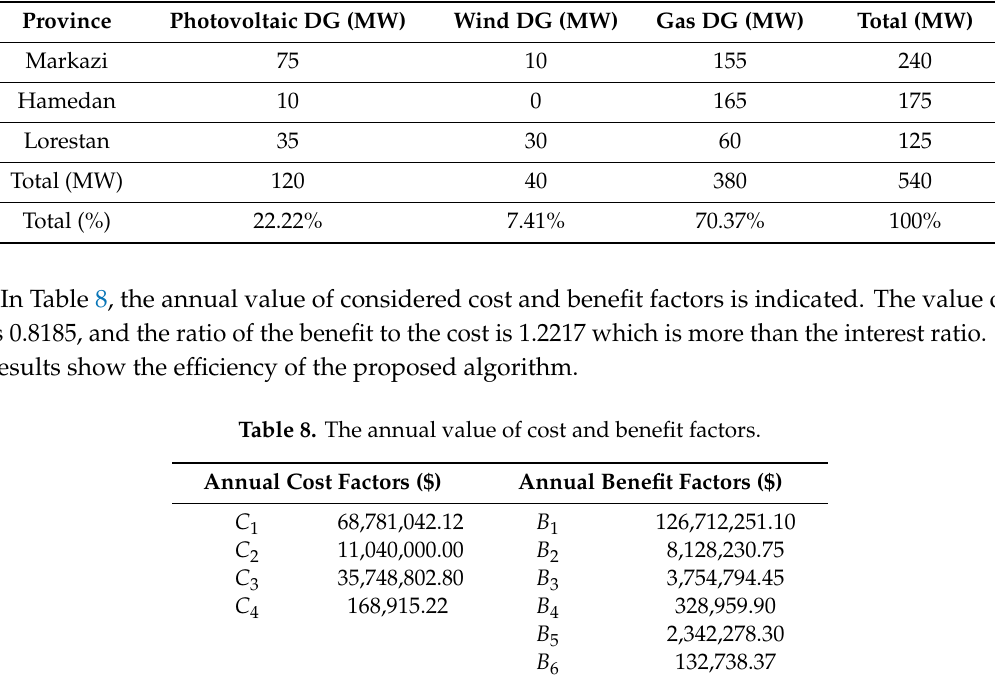
Table 7. The total size of each type of DG resources per province.